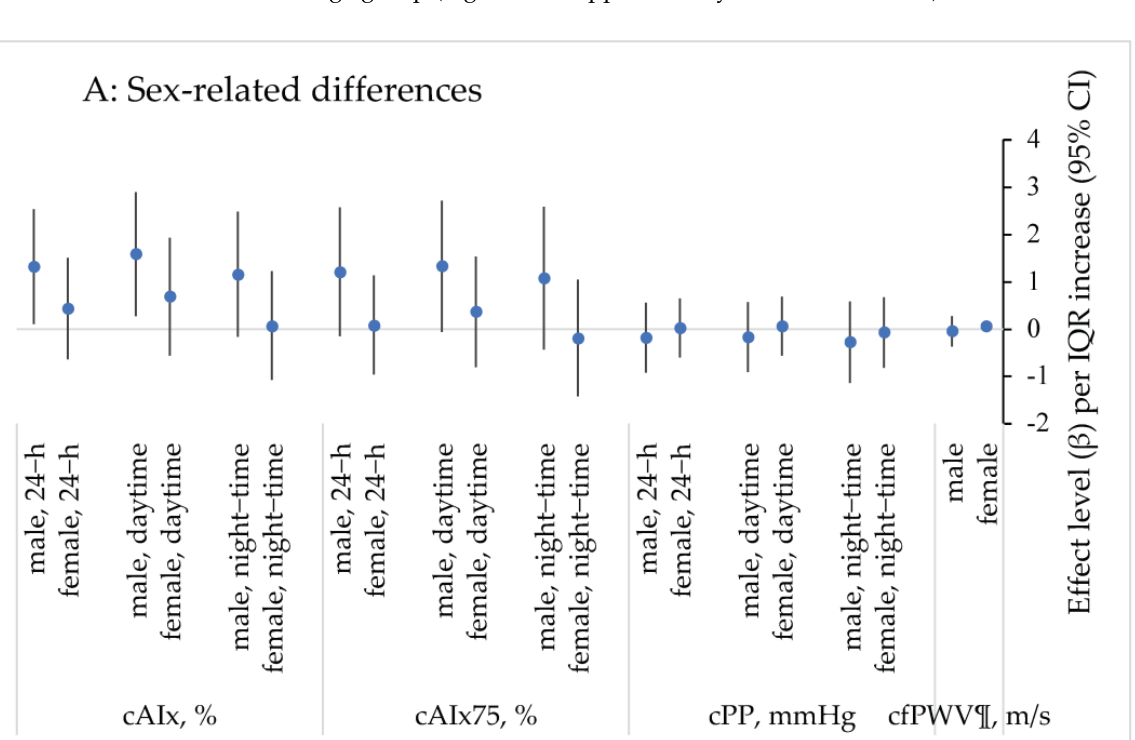
Figure 1. Association between VOCs and measures of arterial stiffness stratified by sex ( A ) and age ( B ). Multiple linear regression; adjusted for age, gender, BMI, waist – hip ratio, socioeconomic status (low, medium, high) and 24-h mean temperature; data are presented as mean change (β) and 95% confidence interval (CI) for one interquartile range (IQR) increase in indoor VOCs; cAIx — central (aortic) augmentation index; cAIx75 — central (aortic) augmentation index normalised for heart rate; cPP — central (aortic) pulse pressure; cfPWV — carotid – femoral pulse wave velocity; ¶ — this measurement was obtained during the clinical pulse wave analysis assessment (rather than as an ambulatory measure). 4. Discussion In this study, we examined the relationship between domestic indoor exposure to total VOCs and subclinical measures of central arterial stiffness in a healthy middle-aged population of men and women, residing in Perth, Western Australia. To our knowledge, this is the first study to investigate the association between exposure to residential indoor